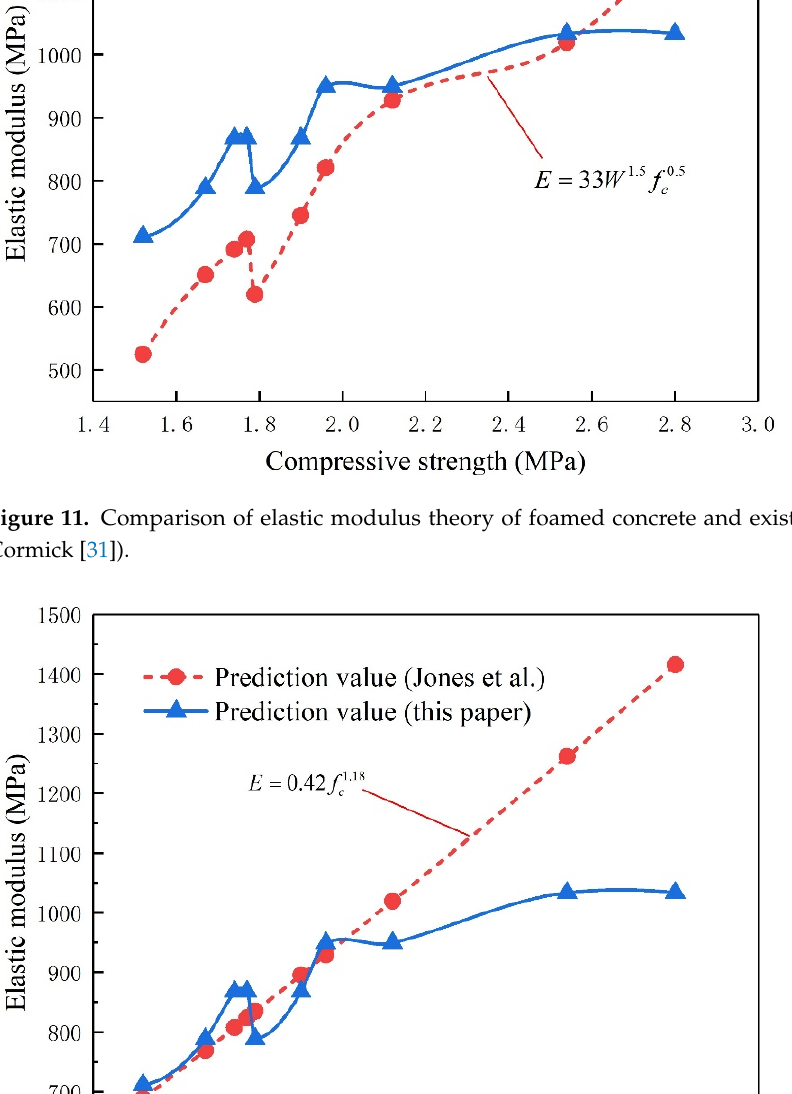
Figure 13. Comprehensive comparison of calculation results of elastic modulus of foamed concrete (Jones et al. [22], McCormick [31] and Tan et al. [41]). It can be seen from Figure 11 that the proposed model and McCormick’s model have a certain similarity in the calculation results. It can be seen from Figure 12 that when the compressive strength is in the range 1.5–2.0 MPa, the calculation results of the proposed model and Jones’s model are relatively close. When the compressive strength of foamed concrete is higher than 2.0 MPa, the difference between the two calculated values be- comes increasingly larger. According to the comparison of elastic modulus values shown in Figure 13, it can be seen that compared with the research results of McCormick, Jones, and Tan, the calcula- tion results of the elastic modulus prediction model of foam concrete proposed in this paper are closer to the experimental data, indicating that the accuracy of this model is better than other models. Therefore, the theoretical model of the elastic modulus of foamed concrete based on the Walsh formula has good rationality.